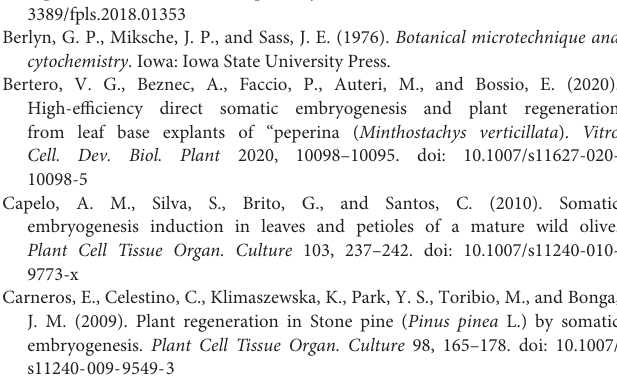
Supplementary Figure 1 | The observation of indirect somatic embryogenesis for cv “Cenruan 2” during embryogenic callus induction stages. (A) The explants 40 days after inoculation, showing the shape of explants and a small amount of induced embryogenic calli on it. (B) 50 days after explants inoculation, showing the soft embryogenic calli. (C) Enlarged image of the stripped embryogenic calli in ( B ; marked in red square) under stereo microscope. Bars = 10 mm in (A–C) . Supplementary Figure 2 | The observation of indirect somatic embryogenesis for the variety of “Huashuo” at different developmental stages. (A) Cotyledons inoculated in medium. (B) Embryogenic calli 50 days after inoculation. (C) Globular embryo 70 days after inoculation. (D) Heart embryo 75 days after inoculation. (E) Torpedo embryo 80 days after inoculation. (F) Cotyledonary embryo 85 days after inoculation. (G) Plantlet with shoots and roots ready for acclimatization 120 days after inoculation. Bars: (A,B,G) = 10 mm, (C,E) = 0.5 mm, and (D,F) = 1